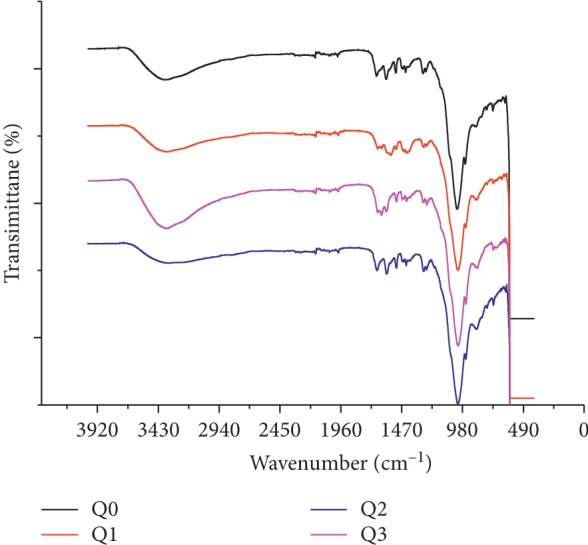
FTIR diffraction spectra.